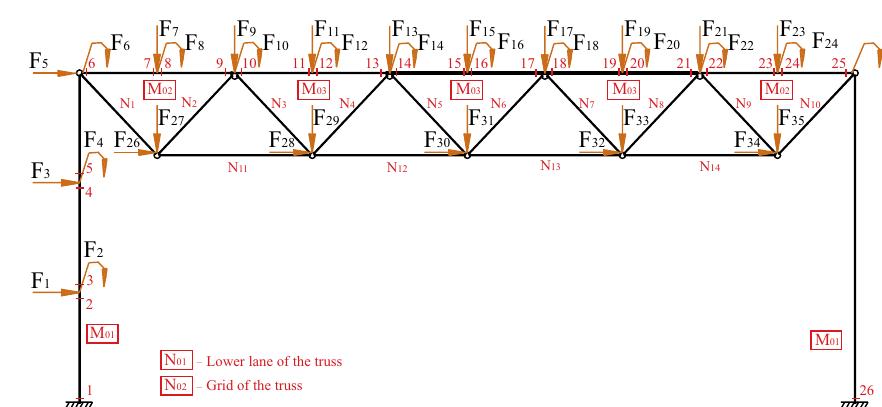
Fig. 2. Discrete model for a steel framing